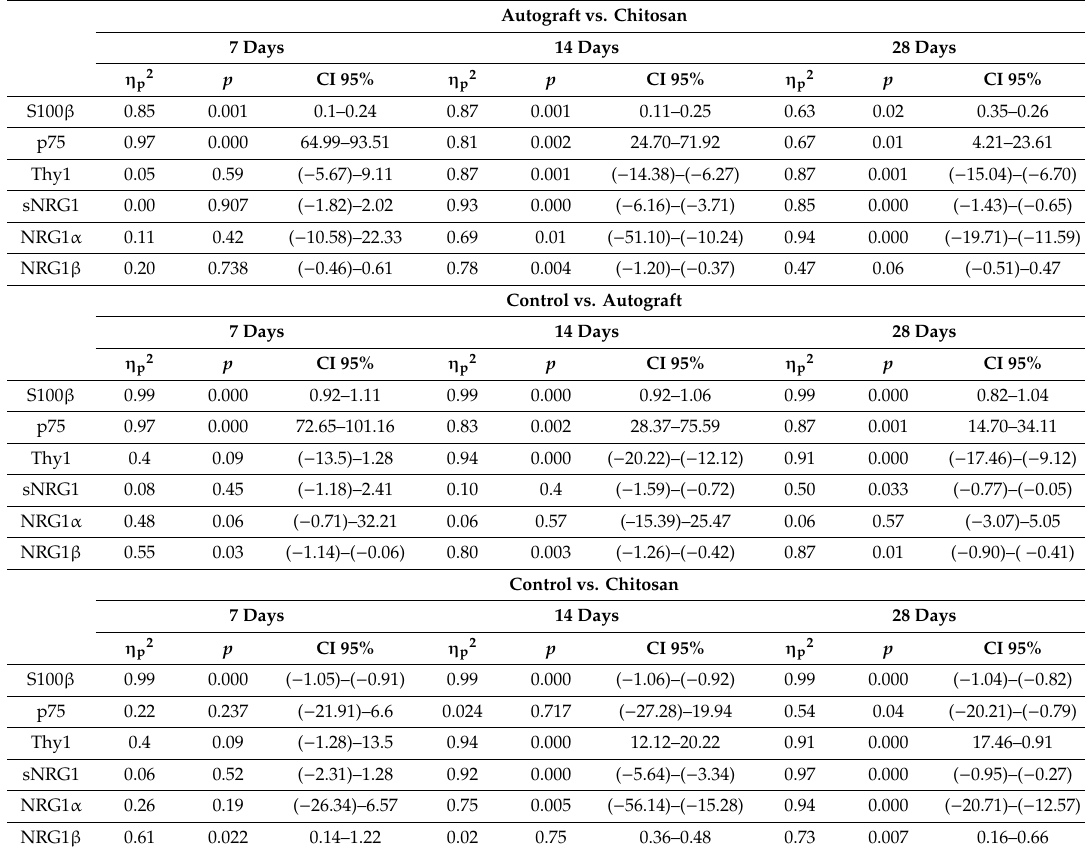
Table 1. ANOVA for repeated measures with Bonferroni’s